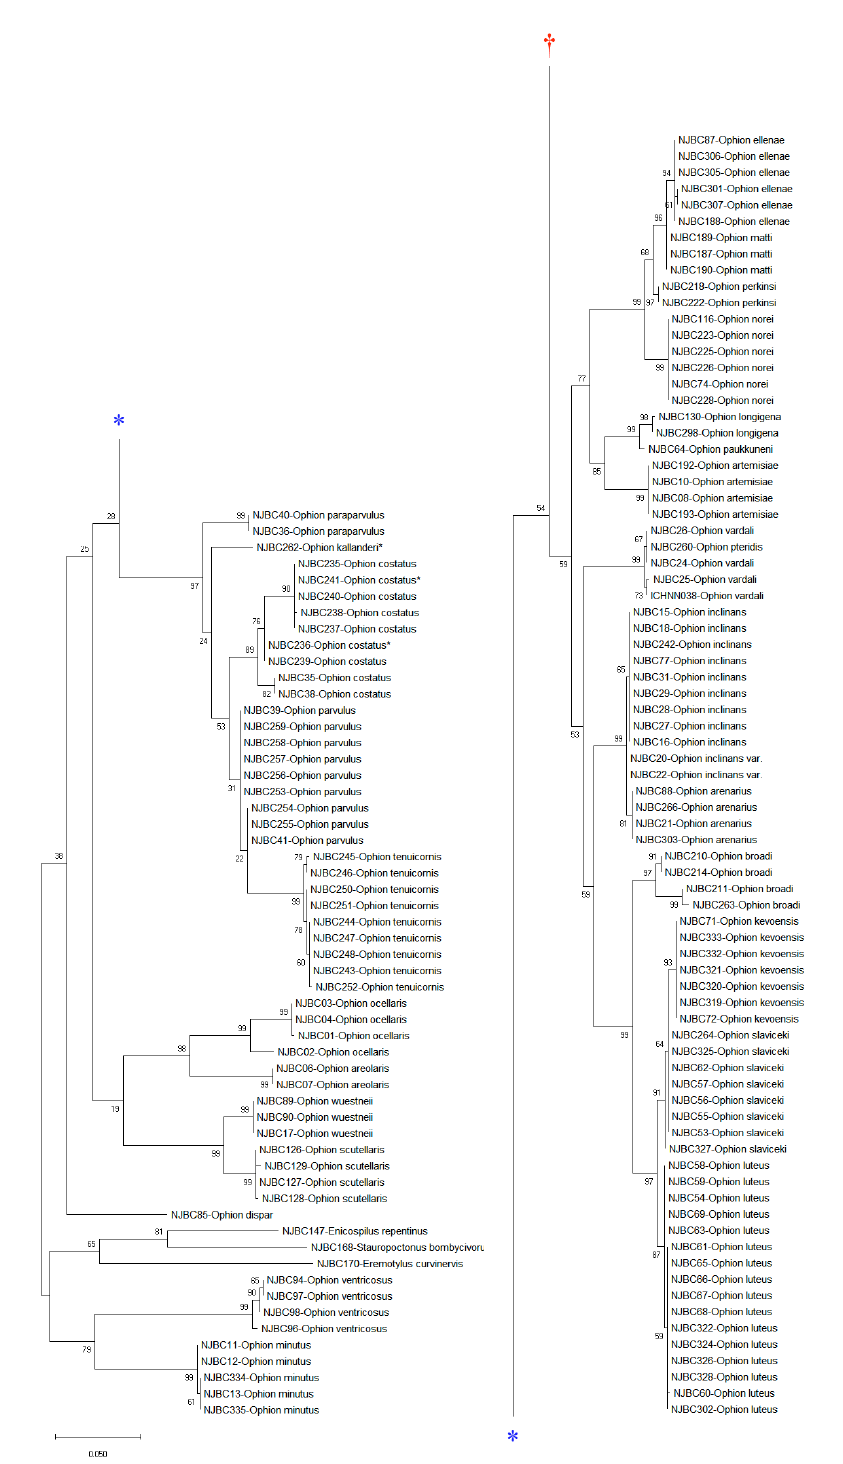
oxidase 1 (CoI) sequences. Maximum likelihood tree is shown with clade support including 234 Ophion and 3 outgroup specimens is shown based on 150 bootstrap iterations using the general Time reversible model and analysed with MEgA-X. The sample ids “NJBC” refer to the BoLD